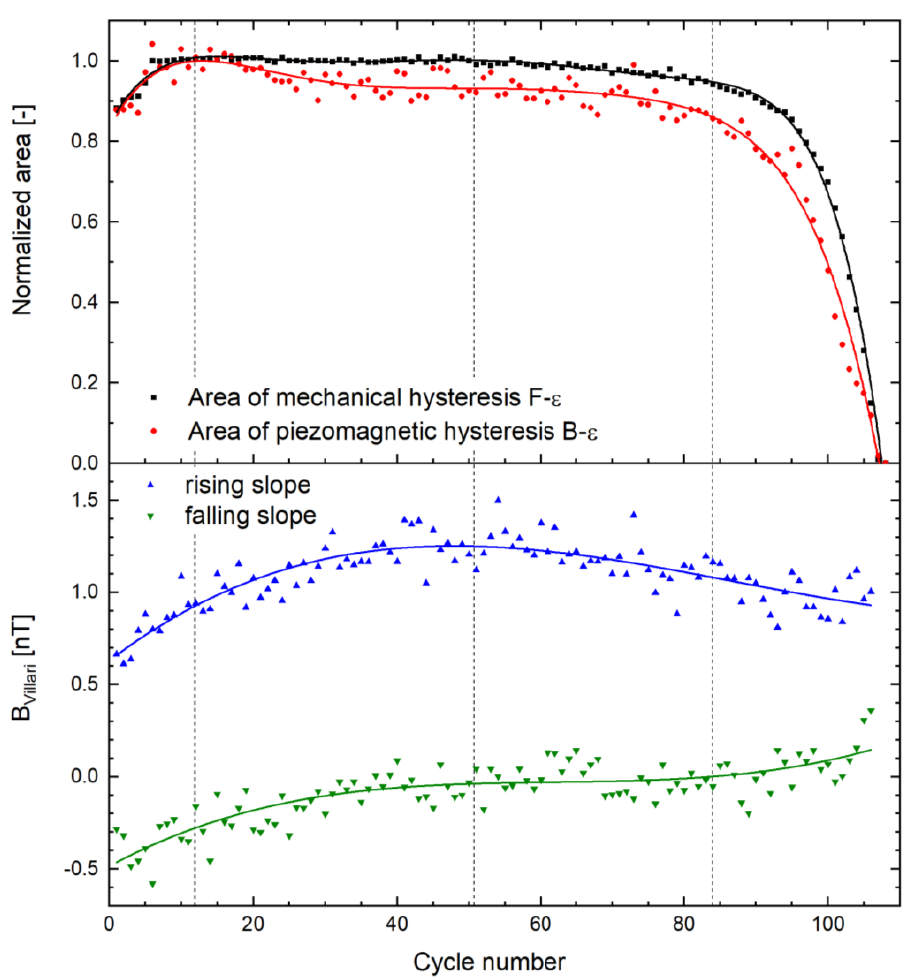
Figure 4. Potential signatures of early fatigue damage processes with an increasing number of cycles. Top: Evolution of the areas of the mechanical ( F − ε ) and piezomagnetic ( B − ε ) hysteresis curves. Bottom: Evolution of the magnetic field at the Villary reversals (arrows on Figure 3) with an increasing number of cycles.